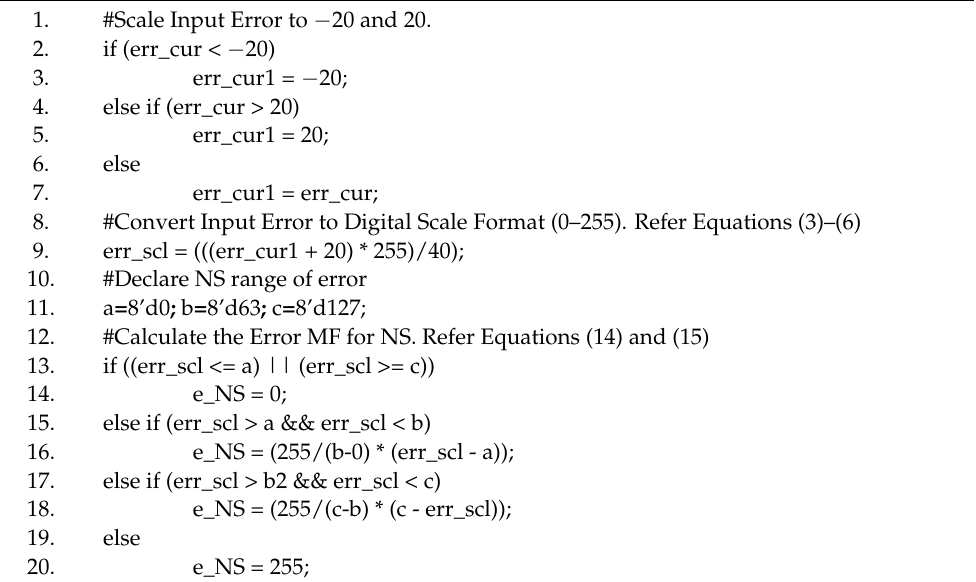
Algorithm 1. Scaling of Input Error and Fuzzification (Negative Small (NS)